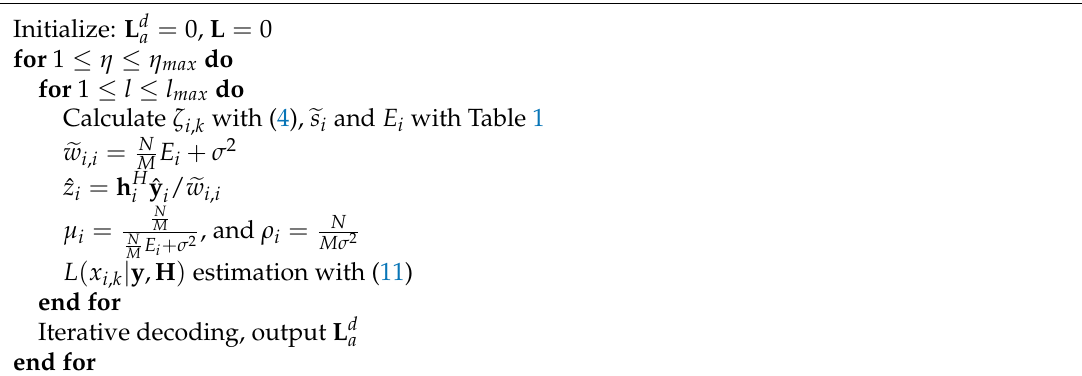
Algorithm 1 Pseudo-code for the proposed complexity reduced MMSE-PIC-based JIDD algorithm